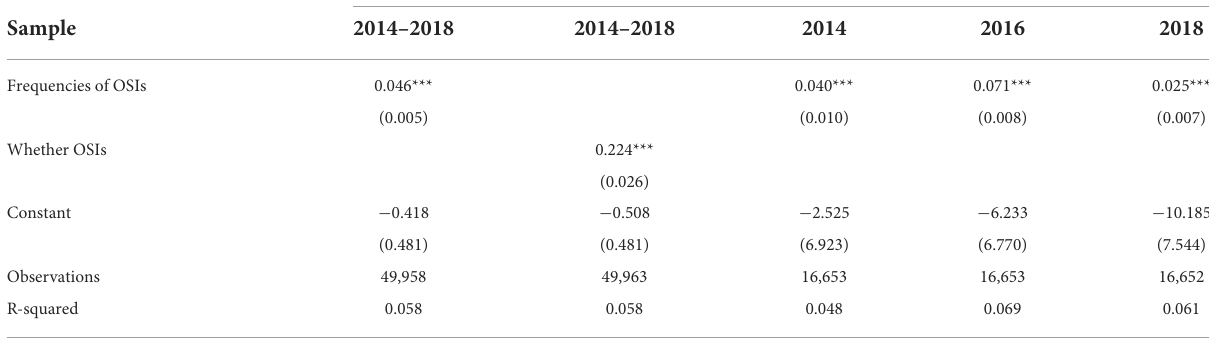
paths are represented. There was a positive association between OSIs and donation ( β = 0.143, p < 0.001). Higher